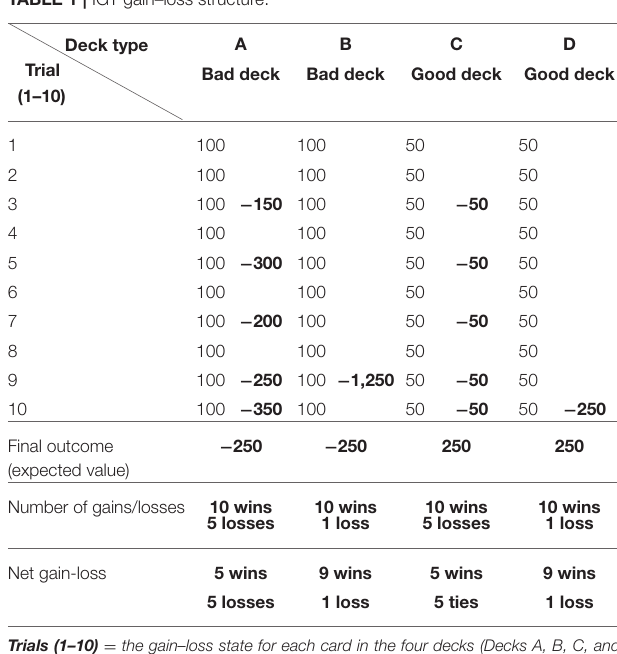
money at the same time each trial. For example, the ninth trial of Deck B could lead to a gain of $100 and a loss of $1,250. However, when the IGT was performed using a 20-trial gain–loss structure, there were slight changes in the order of the cards and the corresponding amount of gains or losses ( Trials 11–20 ). For example, in the 11th to the 20th trials for Deck B, the 14th trial could lead to a gain of $100 and a loss of $1,250. Final outcome (expected value) = tallied results for gains and losses over 10 trials. Number of gains/losses = total number of wins and losses over 10 trials. Net gain– loss = tallied results obtained after adding the amount gained and lost for each card over 10 trials. Source: Table content is based on (10,